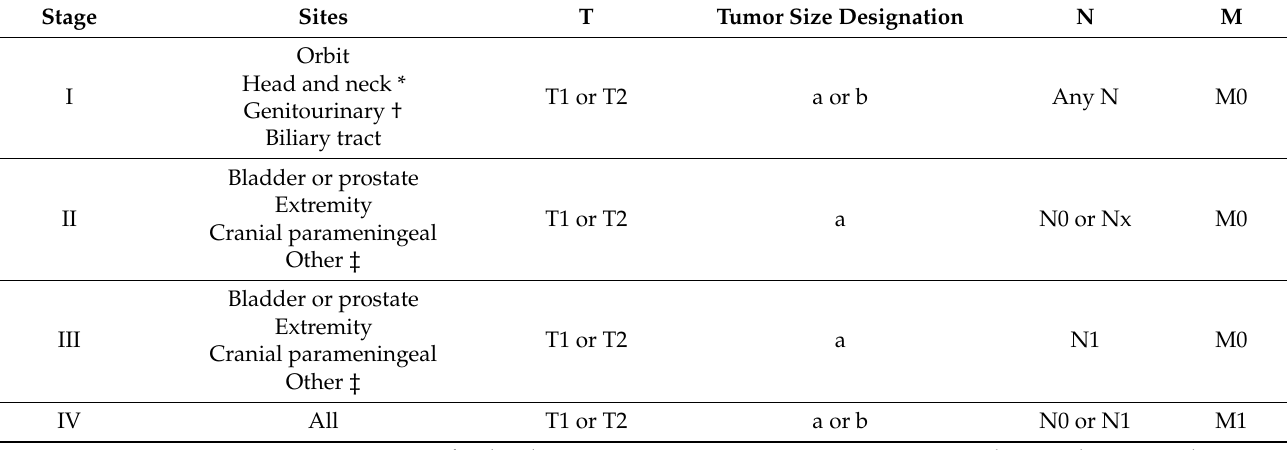
Table 3. TNM Staging System for